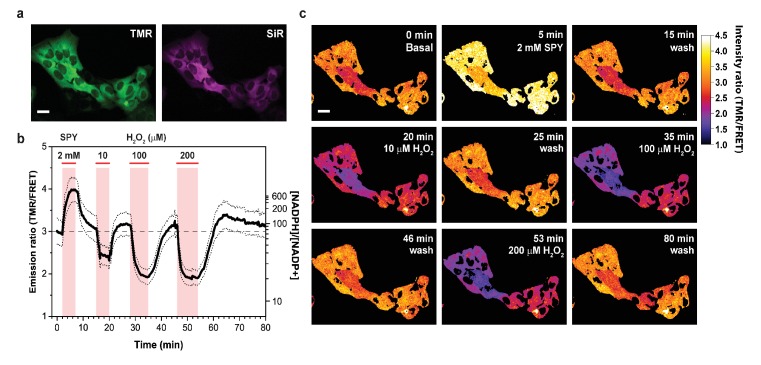
Response of cytosolic NADP-Snifit to H2O2 perfusion.(a) Pseudocolored widefield images of cytosolic NADP-Snifit expressed and labeled in U2OS cells corresponding to the donor channel (TMR, green) and acceptor channel through direct excitation (SiR, magenta). (b) Time course of the FRET ratio (TMR/FRET) of cytosolic NADP-Snifit upon perfusion of 2 mM sulfapyridine (SPY; to determine the FRET ratio of the sensor in the open state in situ) and increasing concentration of H2O2 (10, 100, 200 µM). The continuous line represents the mean ratio ±s.d. (dotted lines) (n = 10 cells). Free NADPH/NADP+ ratios are represented on the right y-axis. The red bars indicate the time span of perfusion. (c) Ratio images of the cytosolic NADP-Snifit at different time points. Scale bars, 30 µm.10.7554/eLife.32638.012Figure 3—source data 1.